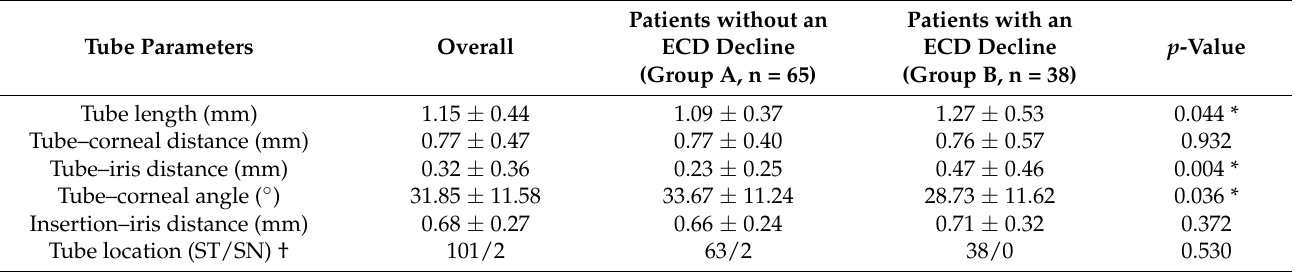
Table 2. Comparison of tube parameters between the patients enrolled in Group A and Group